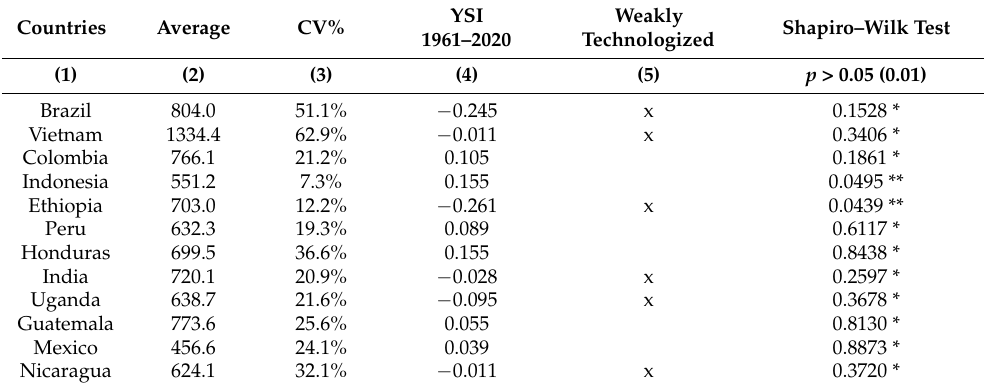
Table 5. Average coffee yields (kg/ha), CV, and YSI for 1961–2020, with normality testing of residual series. Countries